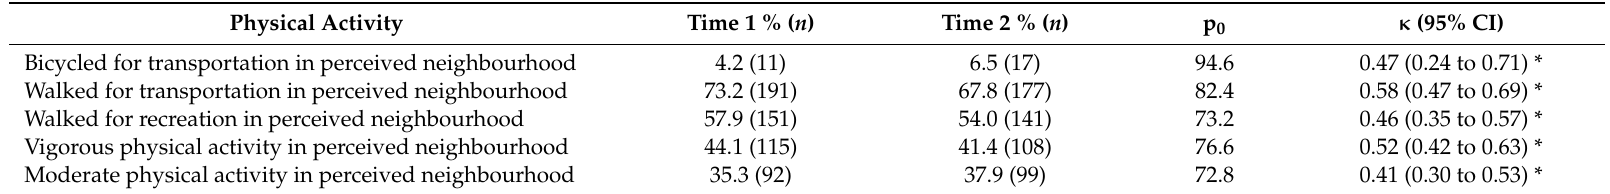
Table 2. Proportion (%) of Overall Agreement (p 0 ) and Kappa ( κ ) coe ffi cients for self-reported physical activity between Time 1 and Time